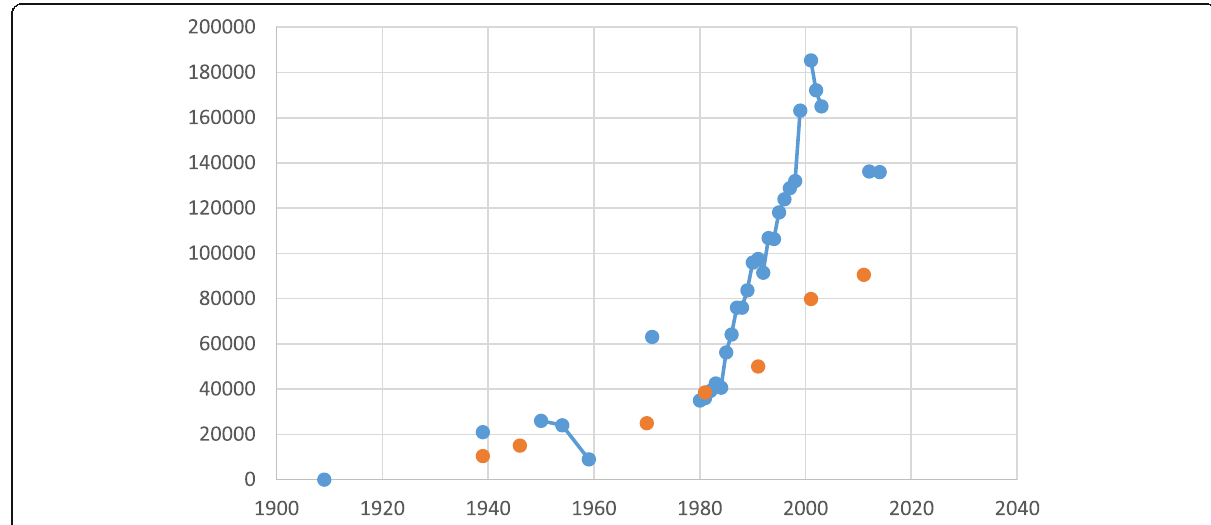
Fig. 2 The dynamics of the regional cattle herd from 1909 to 2015. Source: Veterinary Offices Windhoek, for the years 1996 to 2003 Rep. of Namibia 2004. Housing and Population Census 2001 and 2011; Kruger, C. E. 1984. History of the Caprivi Strip 1890-1984. (unpublished manuscript). NAN